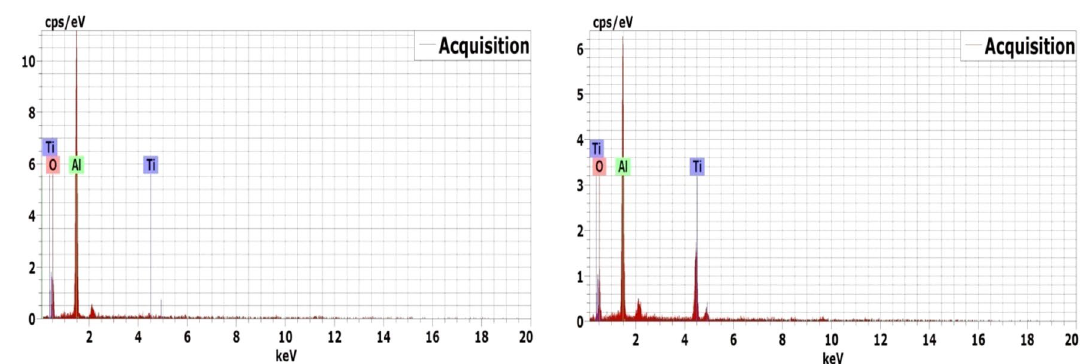
Figure 7. EDS analysis of alumina and aluminum titanate in the sintered 30 R and 40 R composites.